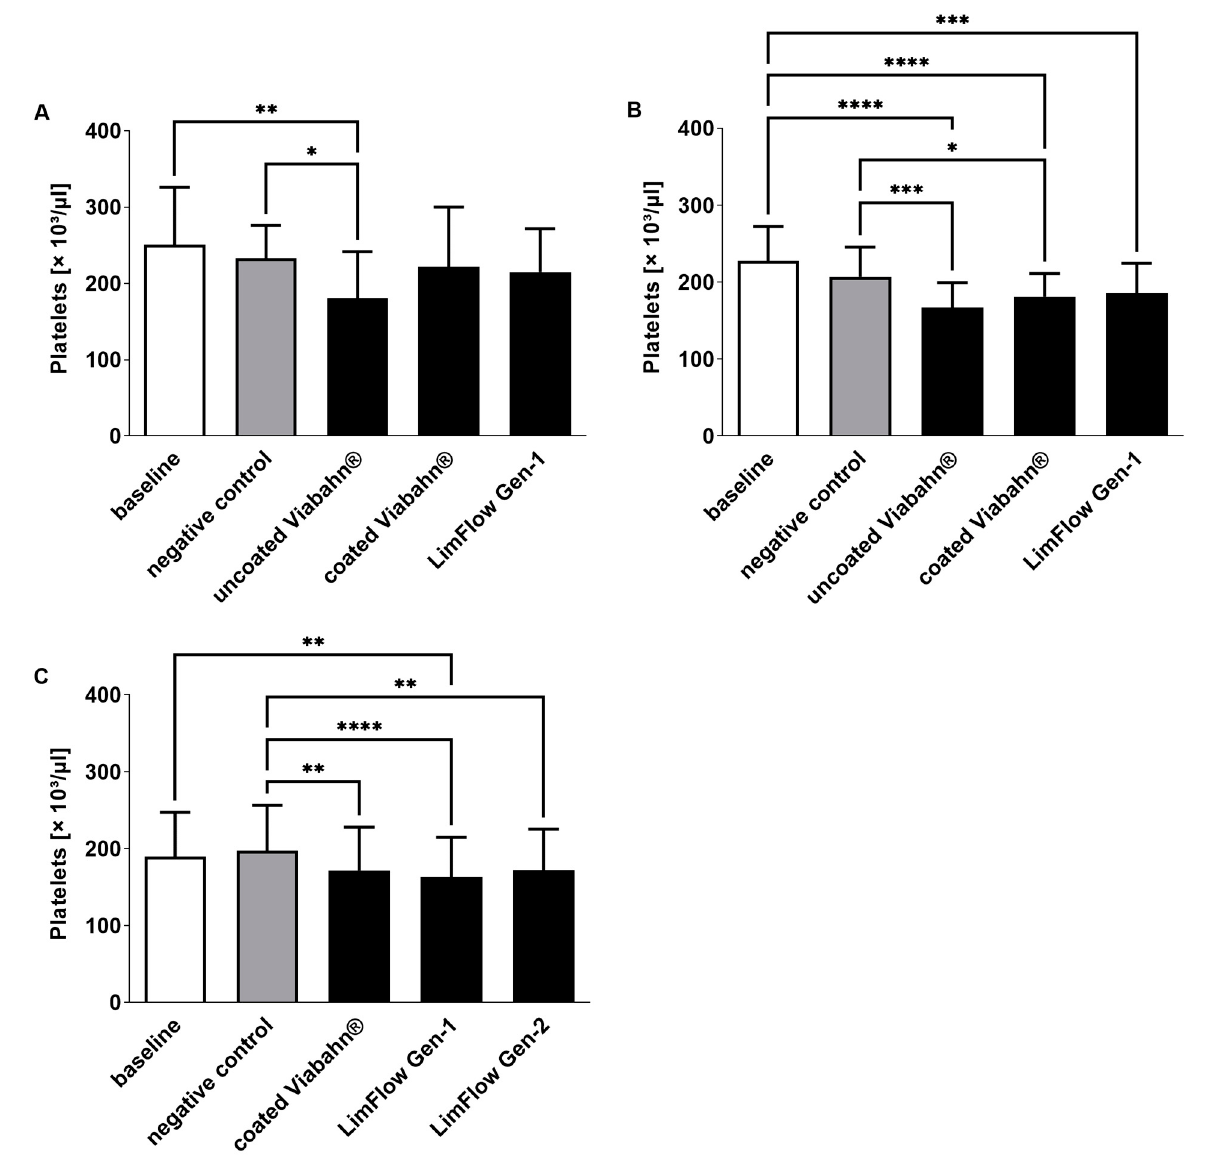
Figure 4. Analysis of platelet counts after the incubation of fresh human blood with test items for 60 min at 37 °C. ( A ) Pilot study ( n = 3), ( B ) Experiment series B ( n = 8), ( C ) Experiment series C ( n = 8). Whole human blood without incubation and contact to test material served as baseline, and blood without test material but incubation as negative control. The data are shown as mean + SD. Statistical differences were determined using one-way ANOVA for repeated measurements followed by Bonferroni’s multiple comparison test. (* p < 0.05, ** p < 0.01, *** p < 0.001, **** p <